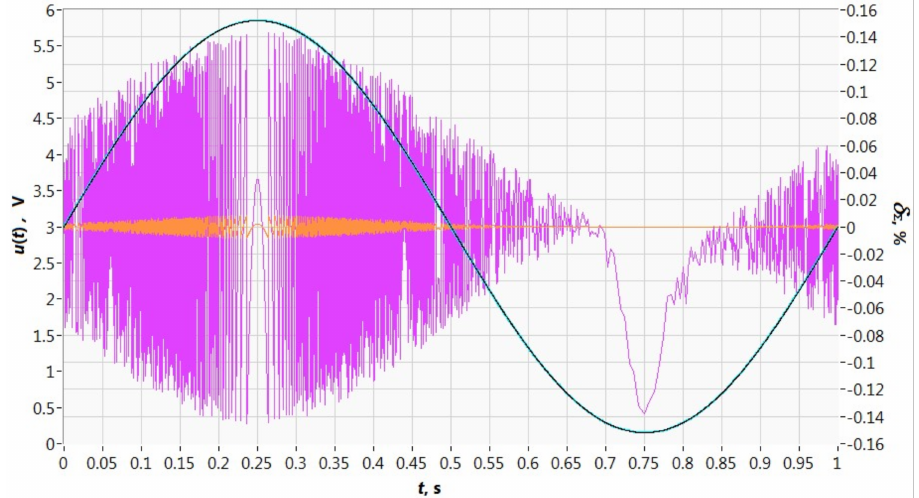
Figure 18. Results of the simulation of test signal processing for the clock signal period of the f/N converter with a value of 0.5 T 0